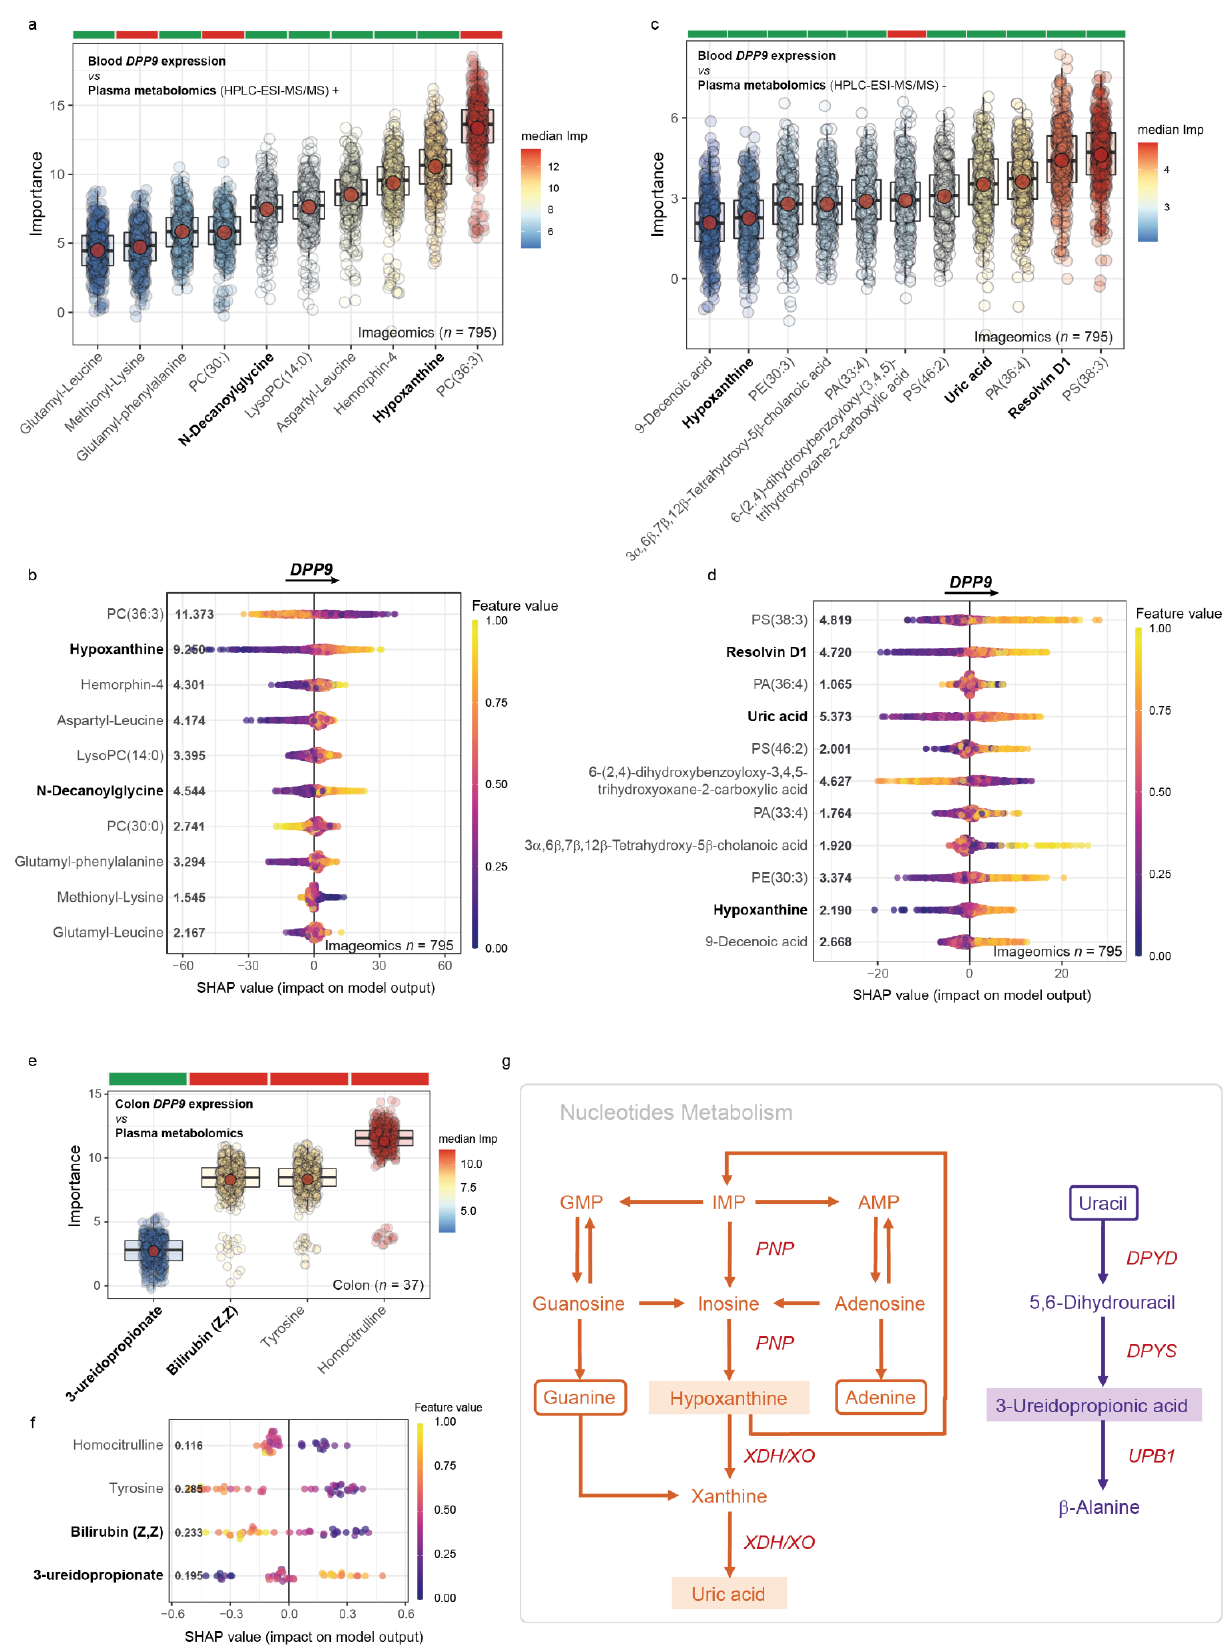
Figure 5. Metabolomics signatures significantly associated with DPP9 expression levels in plasma and colon. ( a , b ) Boxplots of the nomalized variable importance measure (VIM)